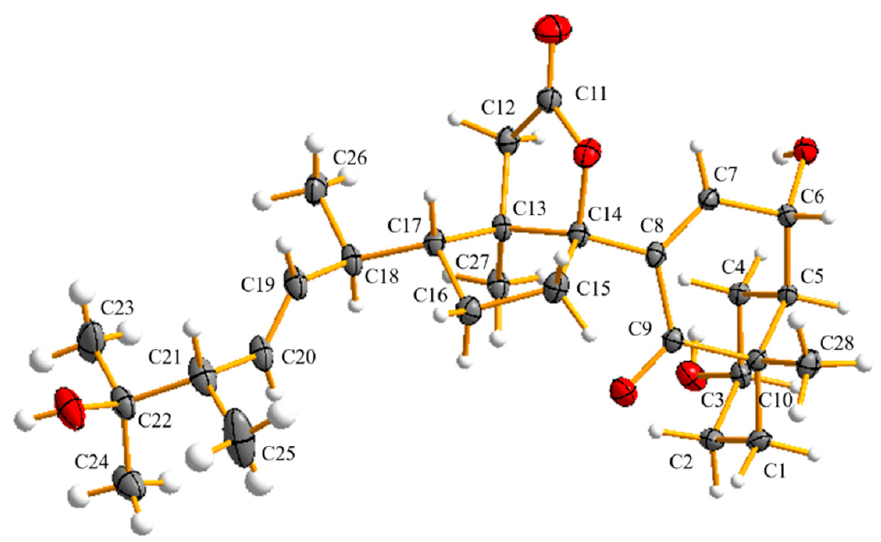
Figure 4. ORTEP drawing of compound 1 .